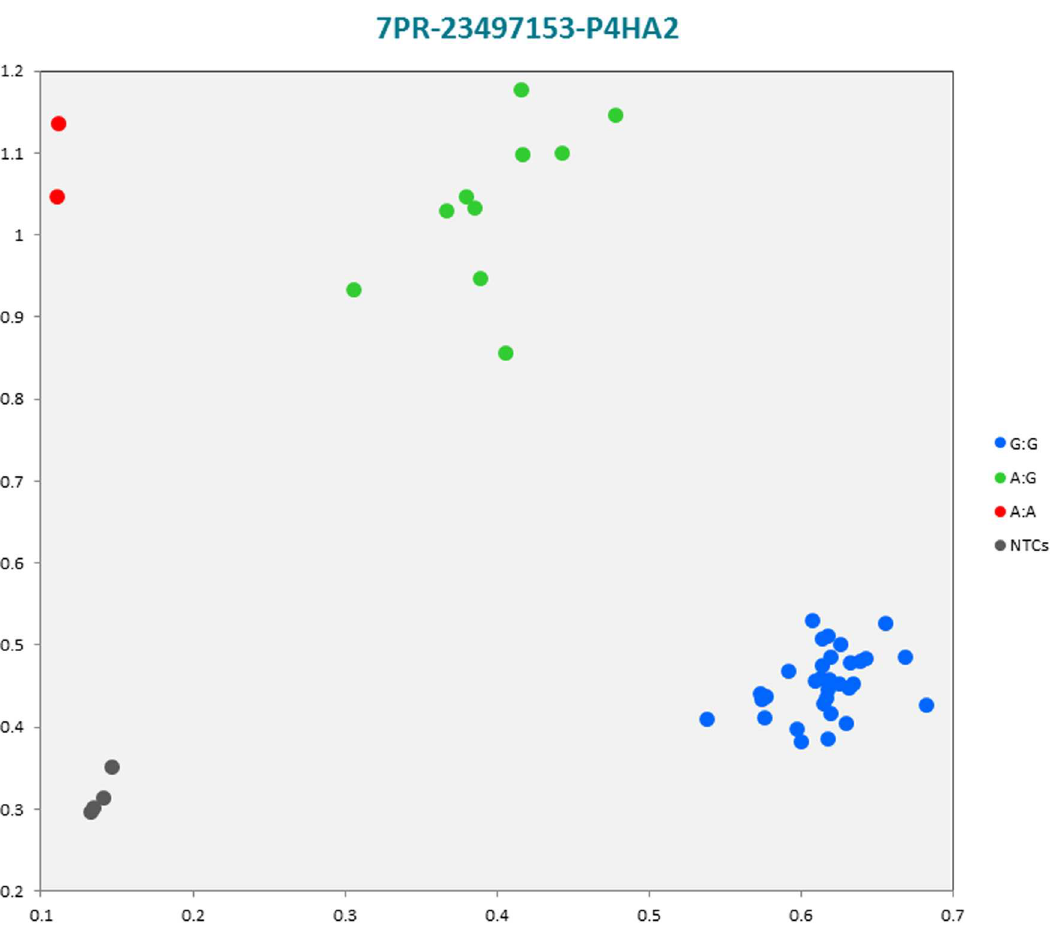
Fig 4. KASP SNP TM genotyping assay of BTA7_23497153locus of Polish Red P4HA2 gene showing the data for single KASP TM assayson a single cluster